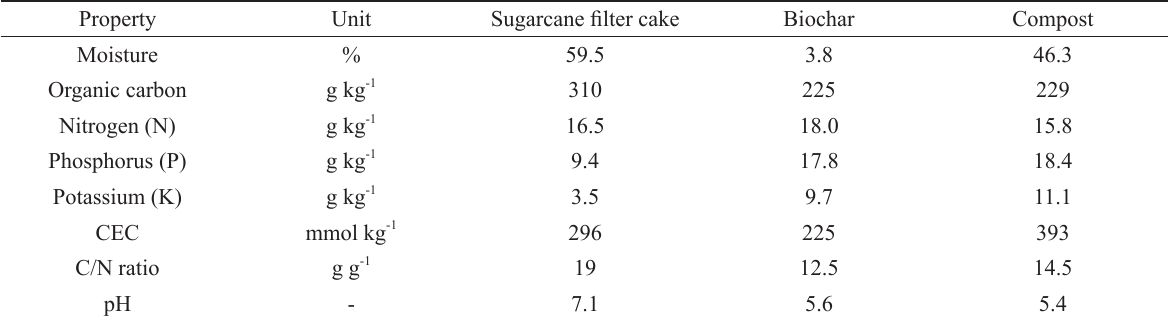
Chemical properties of immature (Sugarcane filter cake), biochar and